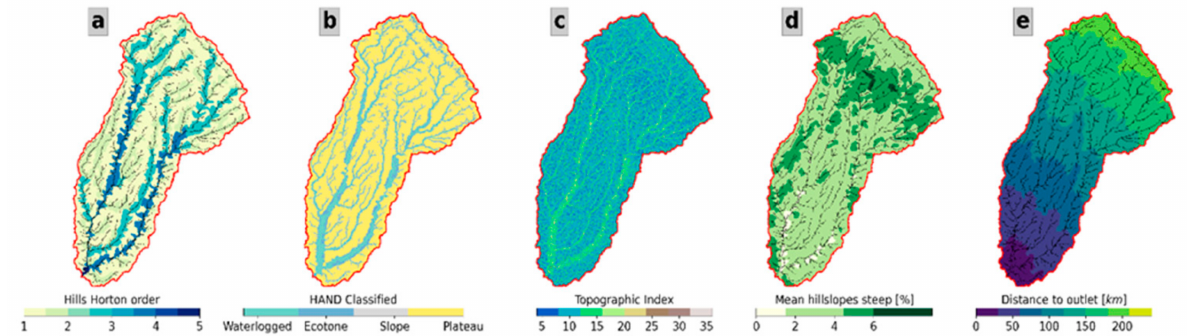
Figure 7. Example of geomorphological maps obtained using WMF. ( a ) Hills colored by the Horton order. ( b ) Cells colored using the [25] HAND classifications. ( c ) Topographic index for each cell of the watershed. ( d ) Hills colored using their mean hillslope. ( e ) Cells colored by the distance to the outlet.